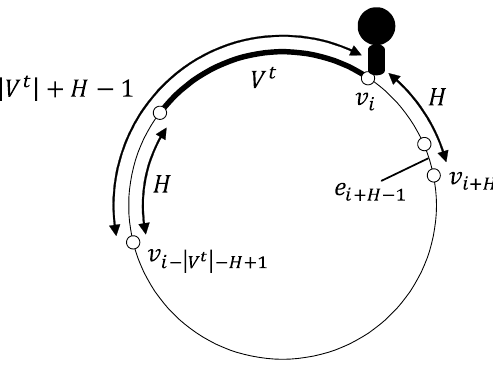
Figure 5. The situation where A exists on v i at the t -th step ( v i is the right extremity of V t ). The adversary deletes e i + H − 1 until the ( t + | V t | + H − 1)-th step in this